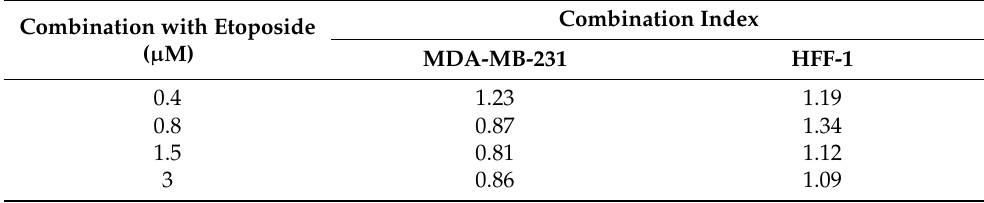
Figure 3. Compound 7 sensitized MDA-MB-231 cells to the effect of etoposide. Cells were treated with a range of concentrations of the conventional chemotherapeutic drug alone and in combination with 1.5 µ M of compound 7 ; cell proliferation was measured after 48 h of treatment; the growth obtained with control (DMSO) was set as 100%; data are mean ± SEM; values significantly different from chemotherapeutic drug alone: * p < 0.05 (two-way ANOVA followed by Sidak’s test). Table 2. Effect of compound 7 in combination with etoposide, in MDA-MB-231 and HFF-1 cells. Combination with Etoposide ( μ M)